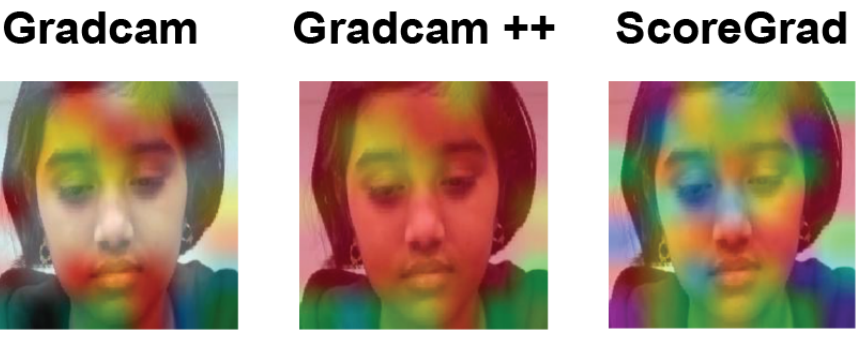
Figure 12. Explained visualization of authors' dataset.